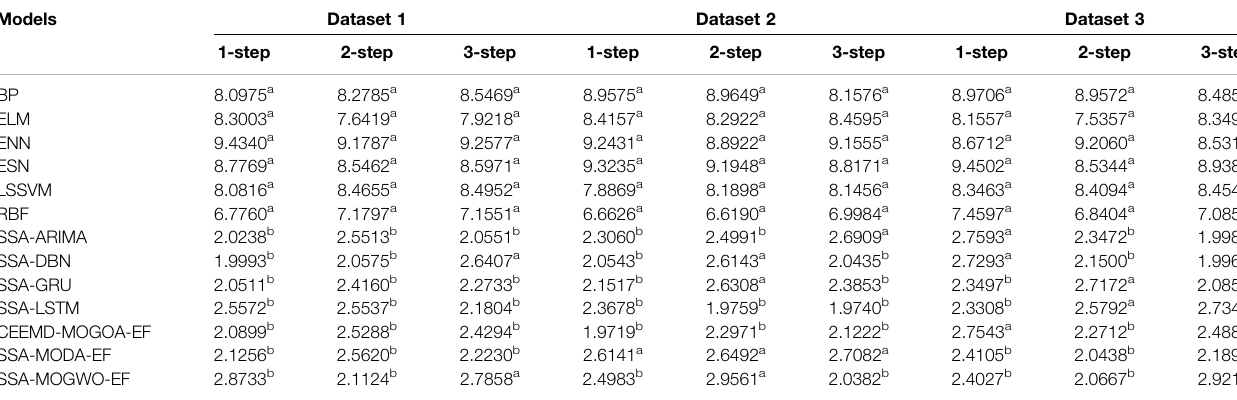
TABLE 7 | DM results of the models included in this study. Models